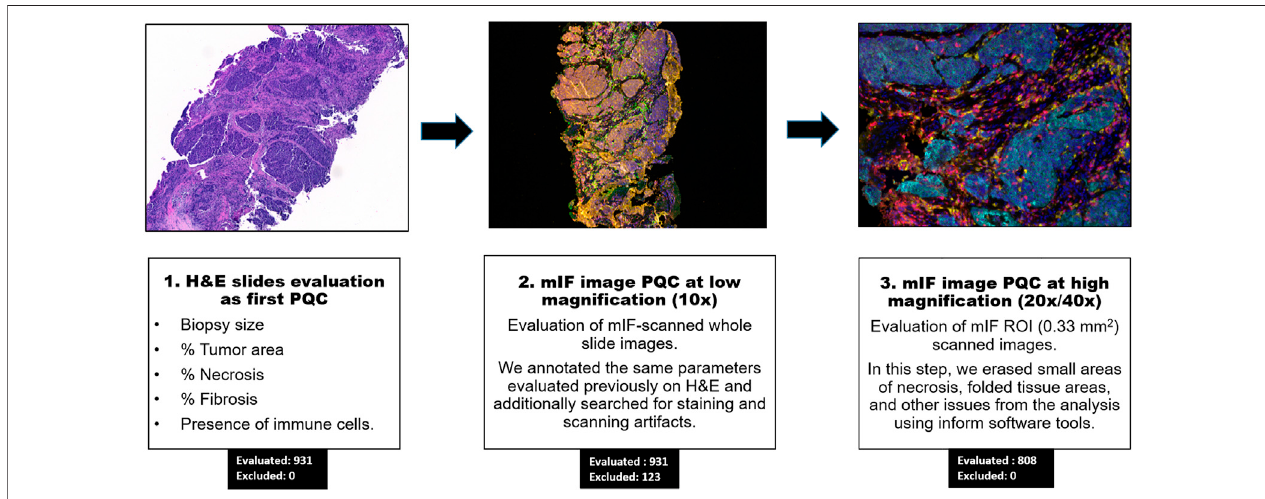
FIGURE 1 | Work fl ow of pathology quality control (PQC) for core needle biopsy sample assessment for multiplex immuno fl uorescence and digital image analysis. Showing the overall three steps of PQC, including assessment of the hematoxylin and eosin (H&E) slides for PQC, image analysis PQC at 10x magni fi cation, and image analysis PQC of region of interest (ROI) images at 20x/40x magni fi cation. The numbers of cases evaluated and excluded at each step are indicated.